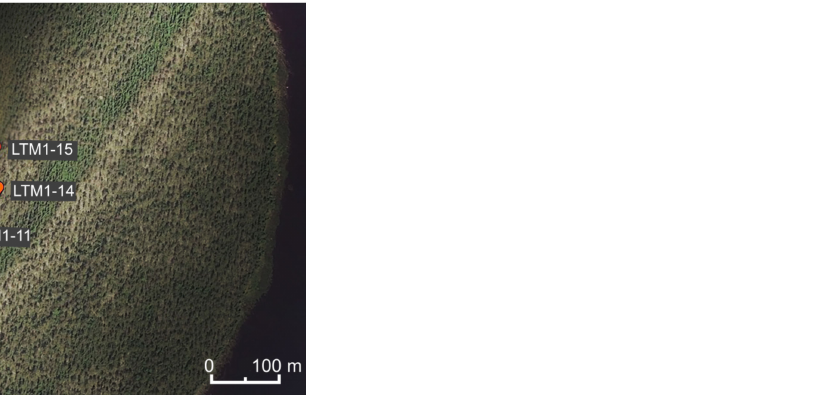
Figure 2. A satellite SAS.Planet image shows the sampling locations in three areas of the orthopyrox- enite zone of the Lotmvara-I sill. The sill (N68 ◦ 08 (cid:48) 37.064 (cid:48)(cid:48) ; E30 ◦ 15 (cid:48) 14.546 (cid:48)(cid:48) ) is exposed largely along the two subparallel rows (gray) of northeastern strike, which are clearly visible on the image.